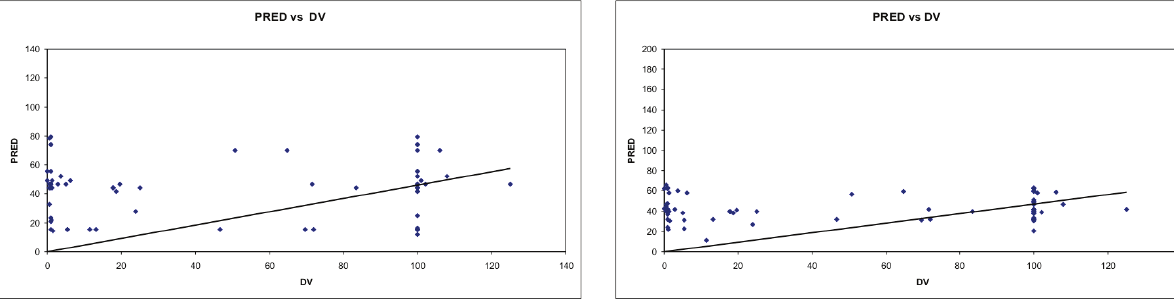
Figure 2: Predicted vancomycin concentrations versus measured concentrations for population with impaired kidney function in the base model (A) and the final model (B), respectively